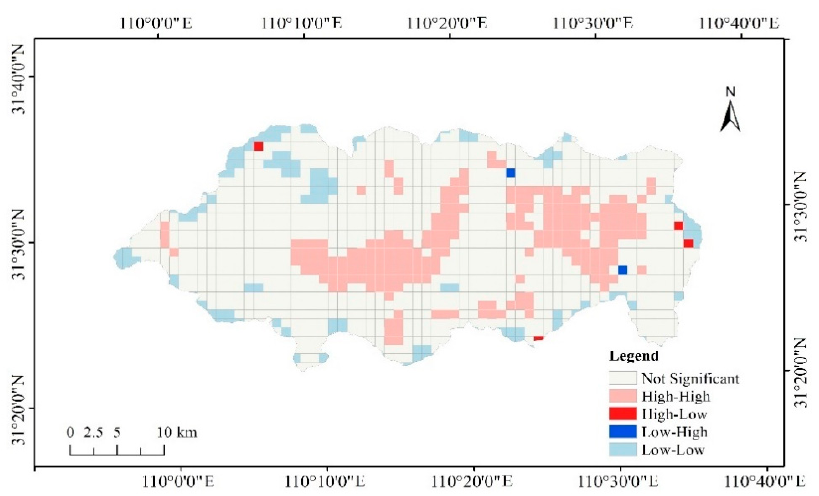
Figure 4. The spatial agglomeration of ecosystem health index in Shennongjia National Park.